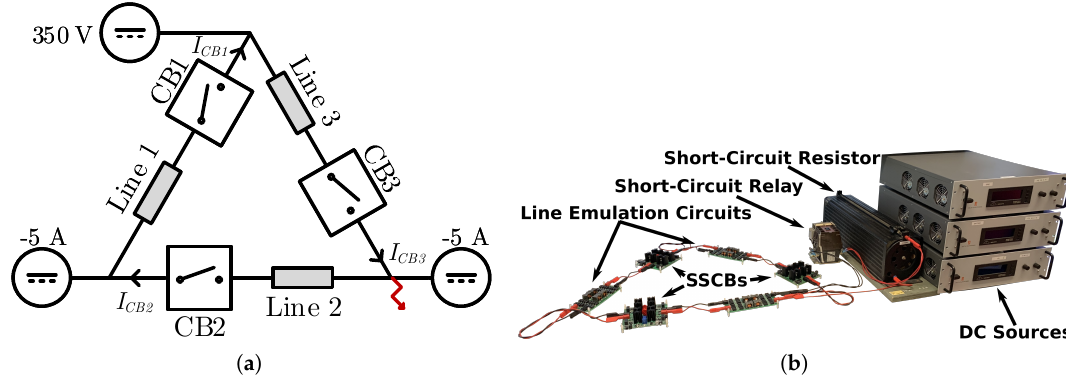
Figure 21. ( a ) Schematic and ( b ) picture of the experimental setup connecting a constant voltage source to two constant current loads via lines in a meshed